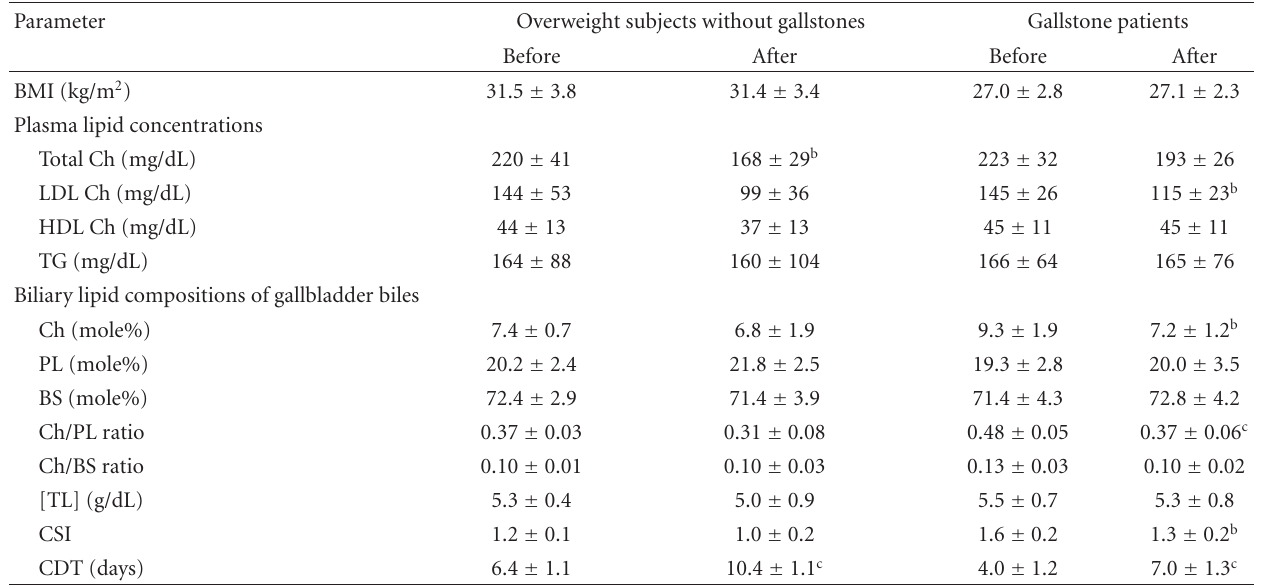
Table 1: Plasma and biliary lipids before (day 0) and at day 30 after ezetimibe treatment in humans (20 mg/day) a . Parameter Overweight subjects without gallstones Gallstone patients Before After Before After BMI (kg/m 2